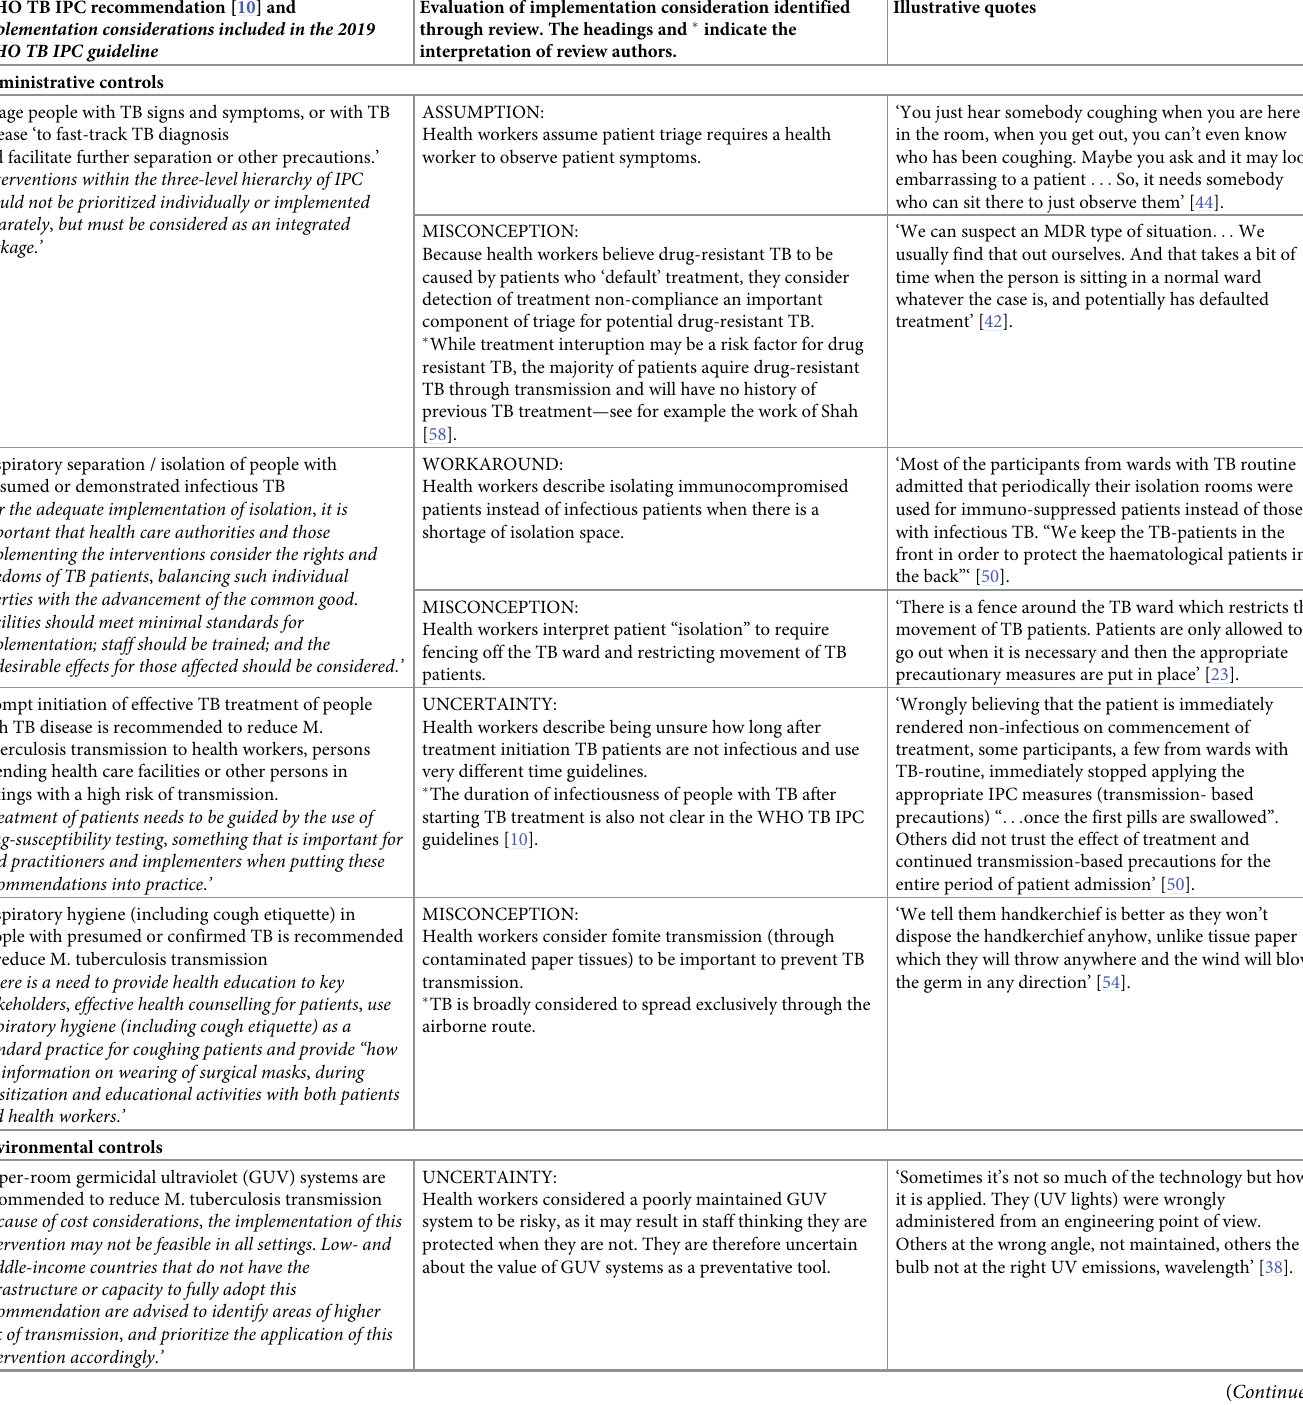
Table 3. Contextualising and evaluating TB IPC implementation considerations identified through this qualitative evidence synthesis. WHO TB IPC recommendation [10] and implementation considerations included in the 2019 WHO TB IPC